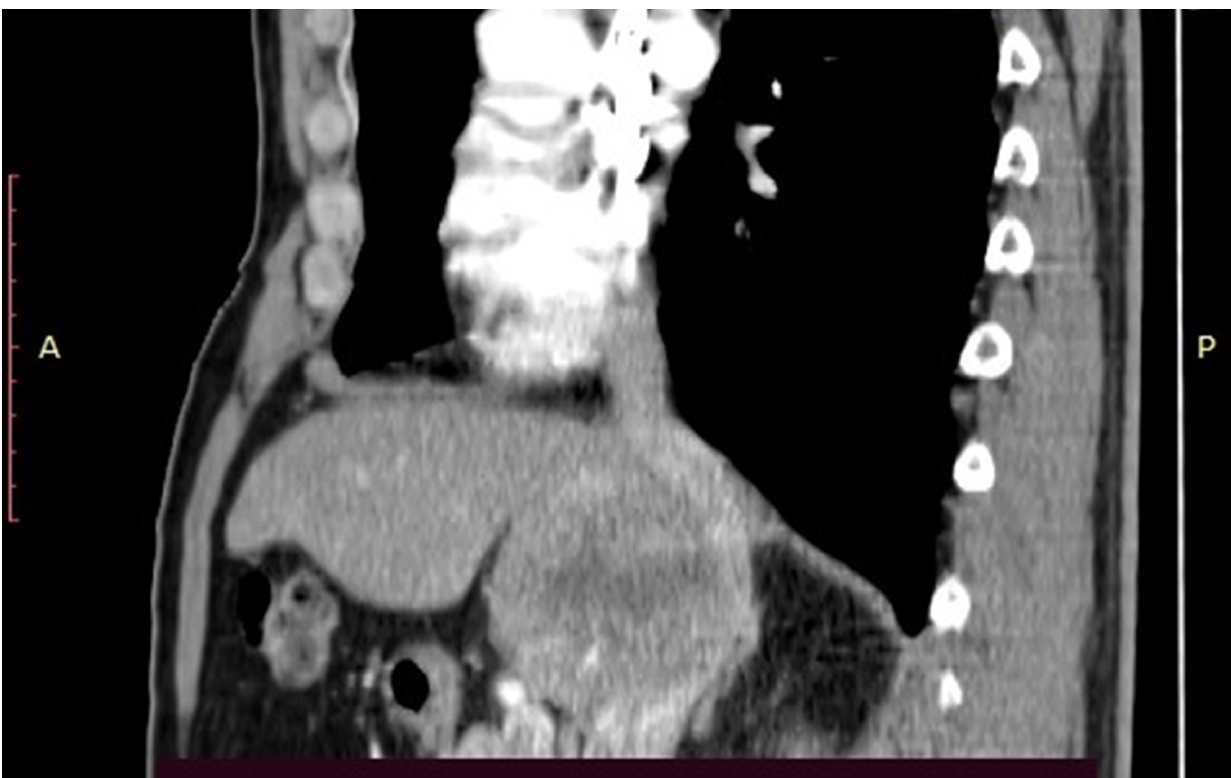
Figure 1. Computed tomography demonstrated the presence of a large tumour invading the inferior cava vein .